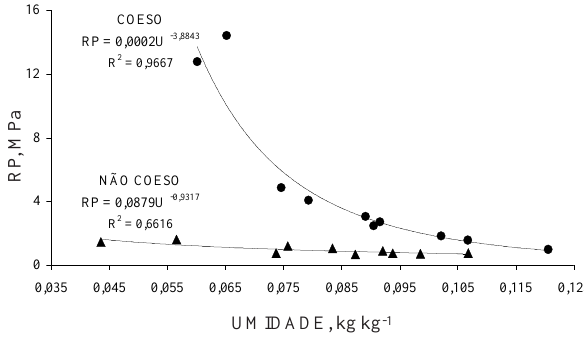
Figura 3. Curvas de resistência à penetração dos horizontes A1 (não-coeso) e AB1 (coeso). As curvas são estatisticamente diferentes (5% ) em umidades inferiores à umidade limite